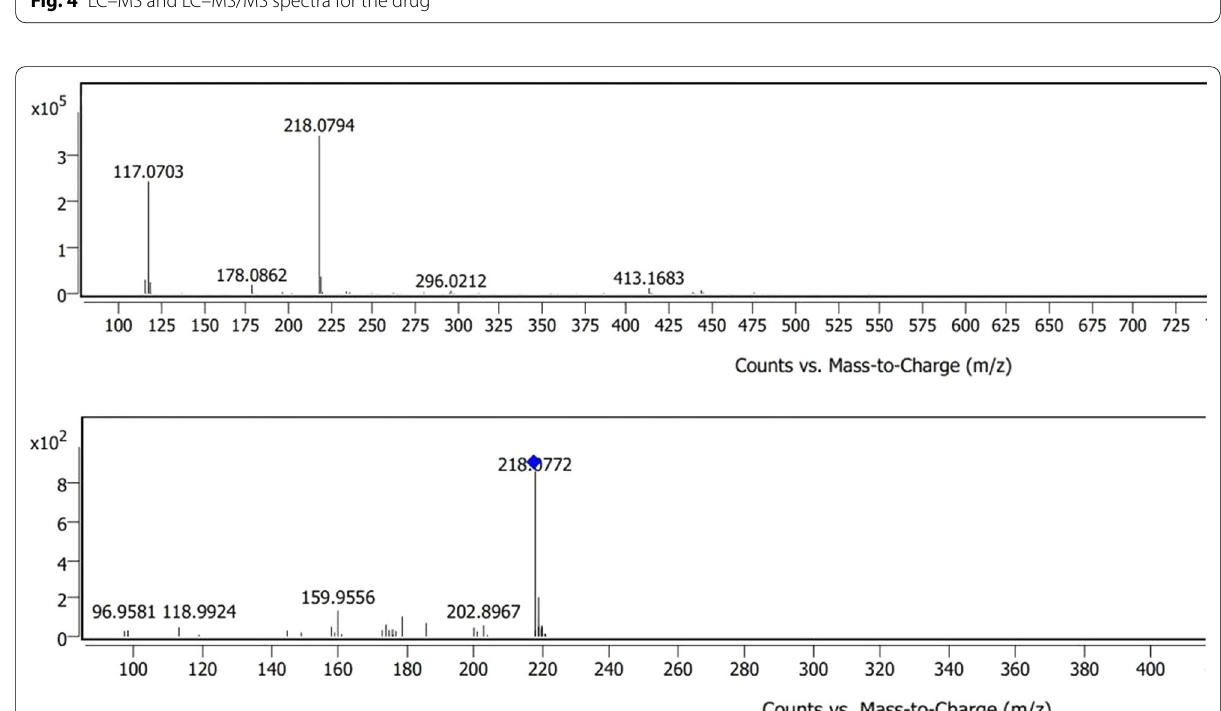
Fig.5 LC–MS and LC–MS/MS spectra for